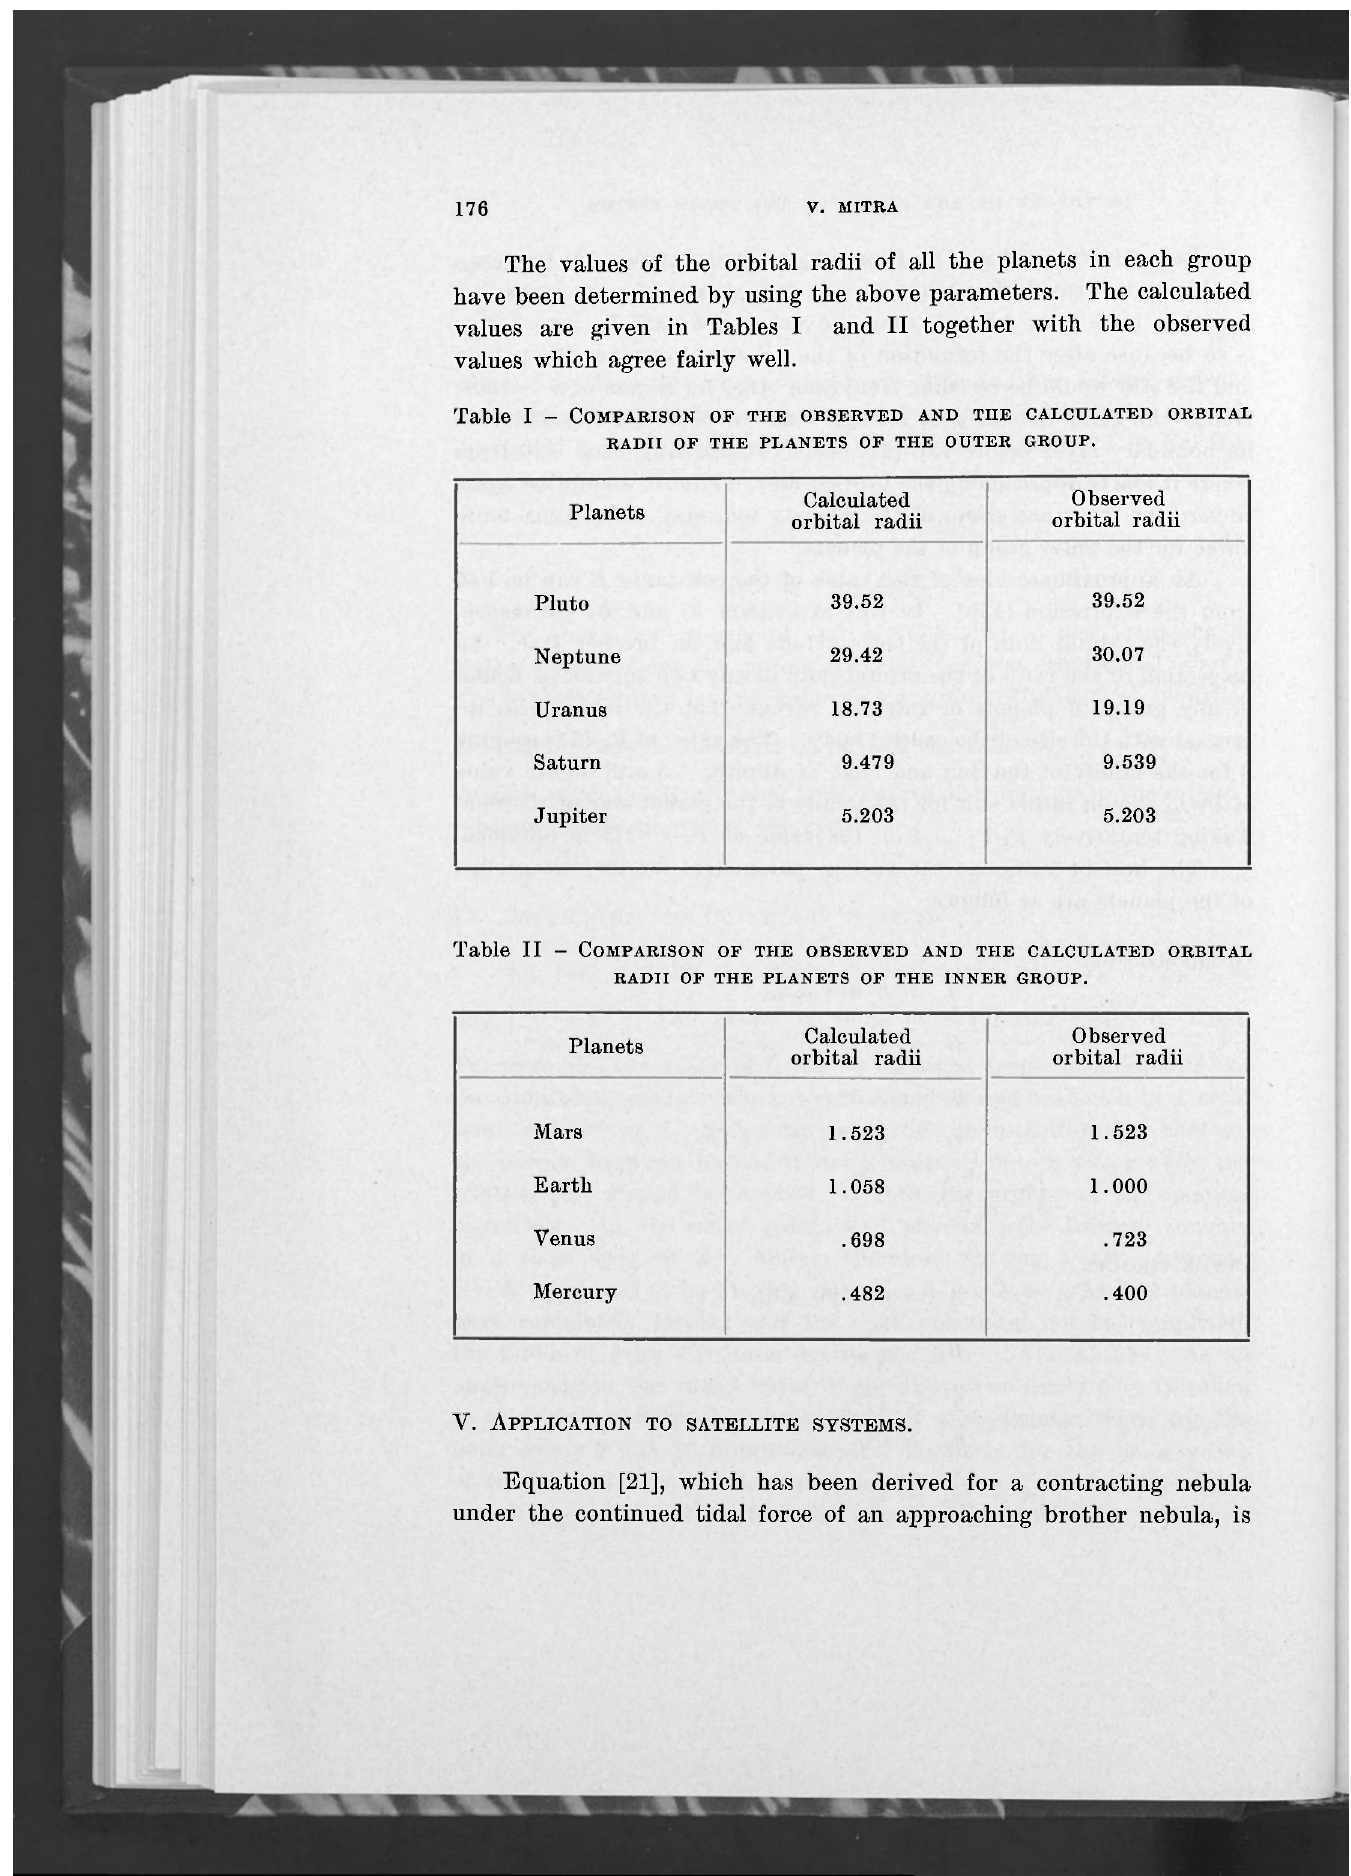
Table I - COMPARISON OF THE OBSERVED AND TIIE CALCULATED ORBITAL RADII OF THE PLANETS OF THE OUTER GROUP.